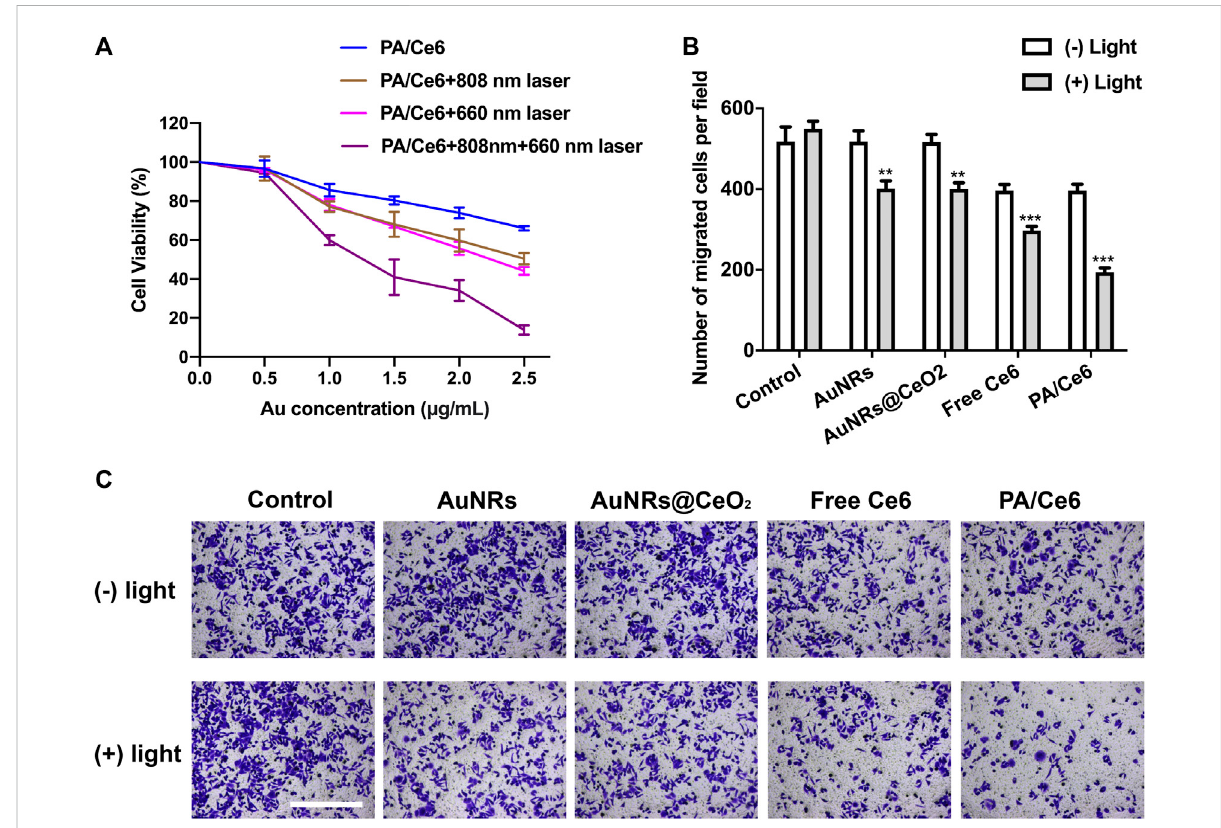
FIGURE 4 (A) Cell viability (OD value) of HepG2 cells treated with PA/Ce6 (with/without NIR laser irradiation) at various Au concentrations at pH 7.4. (B,C) Number of cells of migration after treating with AuNRs, AuNRs@CeO 2 , free Ce6, and PA/Ce6 [with/without NIR laser irradiation